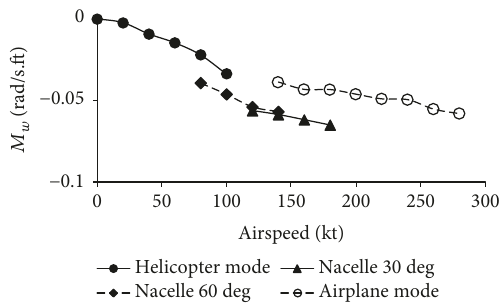
Figure 12: Variation of the derivative M